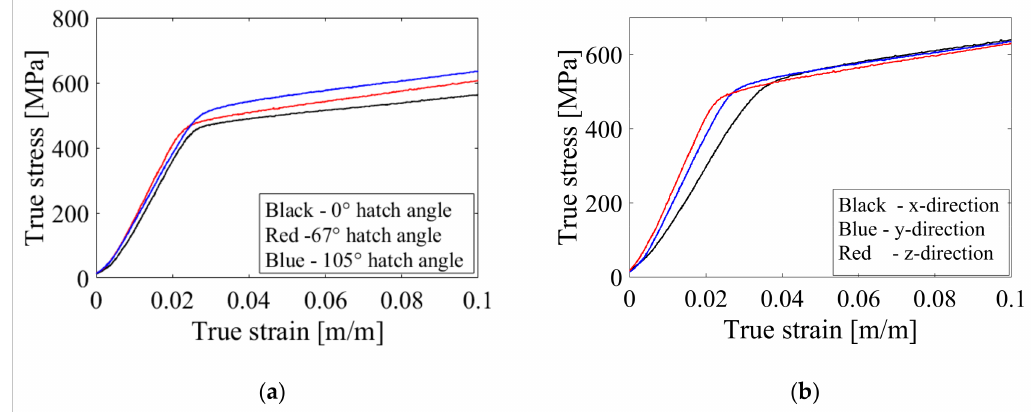
Figure 7. True stress–strain curve of SLM 304L stainless steel showing the elastic region: ( a ) samples built with three hatch angles in the y-direction, ( b ) samples built in three orientations using hatch angle of 105 ◦